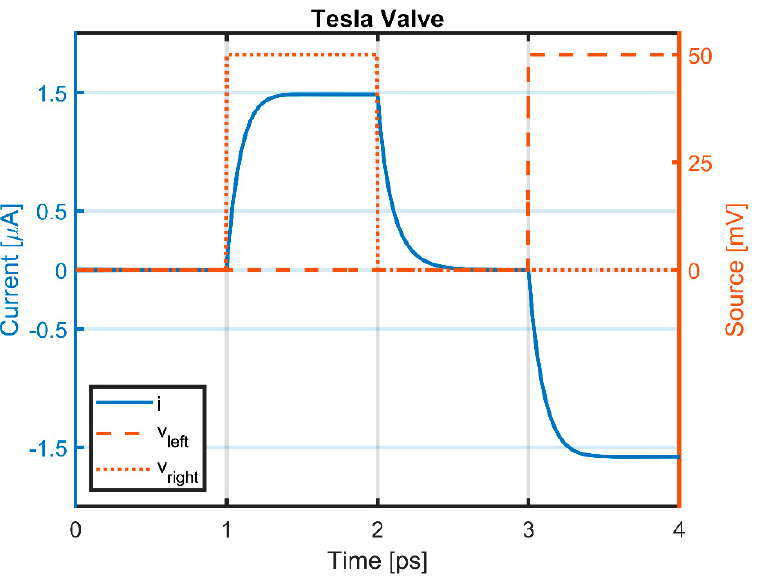
Figure 4. Transient voltage and current profiles of the Tesla valve during “easy” and “hard” flow modes. Between 1–2 ps, a bias in the ‘hard’ flow direction is applied, i.e., the right contact is biased to 50 mV while the left contact is kept grounded. Between 3–4 ps, the biased is reversed to facilitate current in ‘easy’ direction. The computed current level between 3–4 ps is higher than the current levels observed in the ‘hard’ flow direction between 1–2